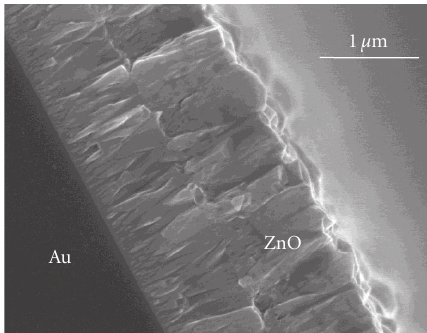
Figure 8: SEM image of the cross-section of the ZnO film.